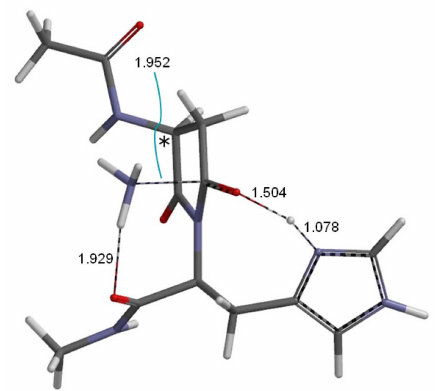
Figure 7. The optimized geometry of TS2, the transition state of the second step (deammoniation from the protonated intermediate, INT2) ( ϕ N = ´ 174 ˝ , ψ N = ´ 116 ˝ , χ 1N = 103 ˝ , ϕ H = ´ 74 ˝ , ψ H = 112 ˝ , ˝ ). Relevant interatomic distances are shown in Å. The asterisked carbon corresponds to the χ 1H = ´ 62 Asn α carbon in the reactant R.